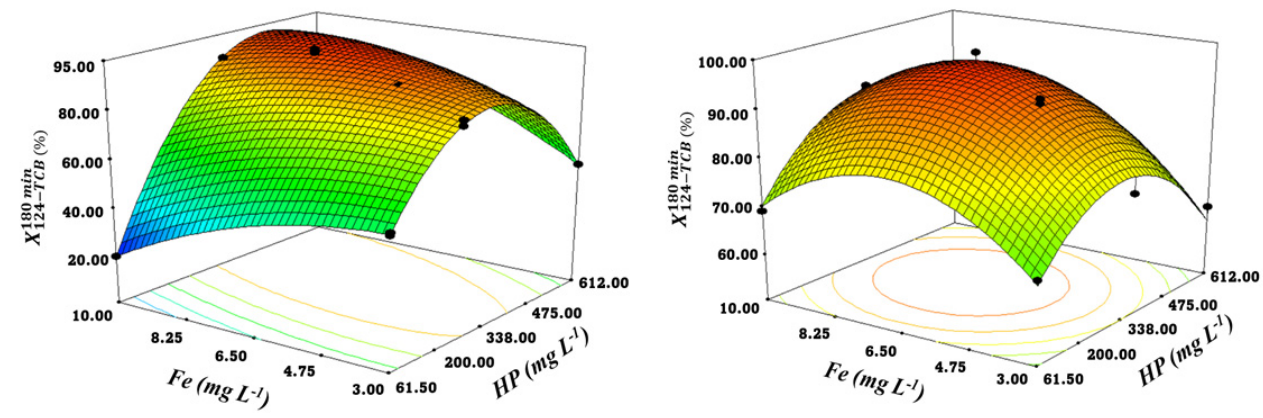
Figure 4. Response surface and experimental values (symbols) for 124-TCB conversion ( X 180 min ) vs HP and Fe concentrations. Experimental conditions: 124-TCB = 28 mg L -1 , ( Left ) Low rad intensity and ( Right ) High rad intensity.